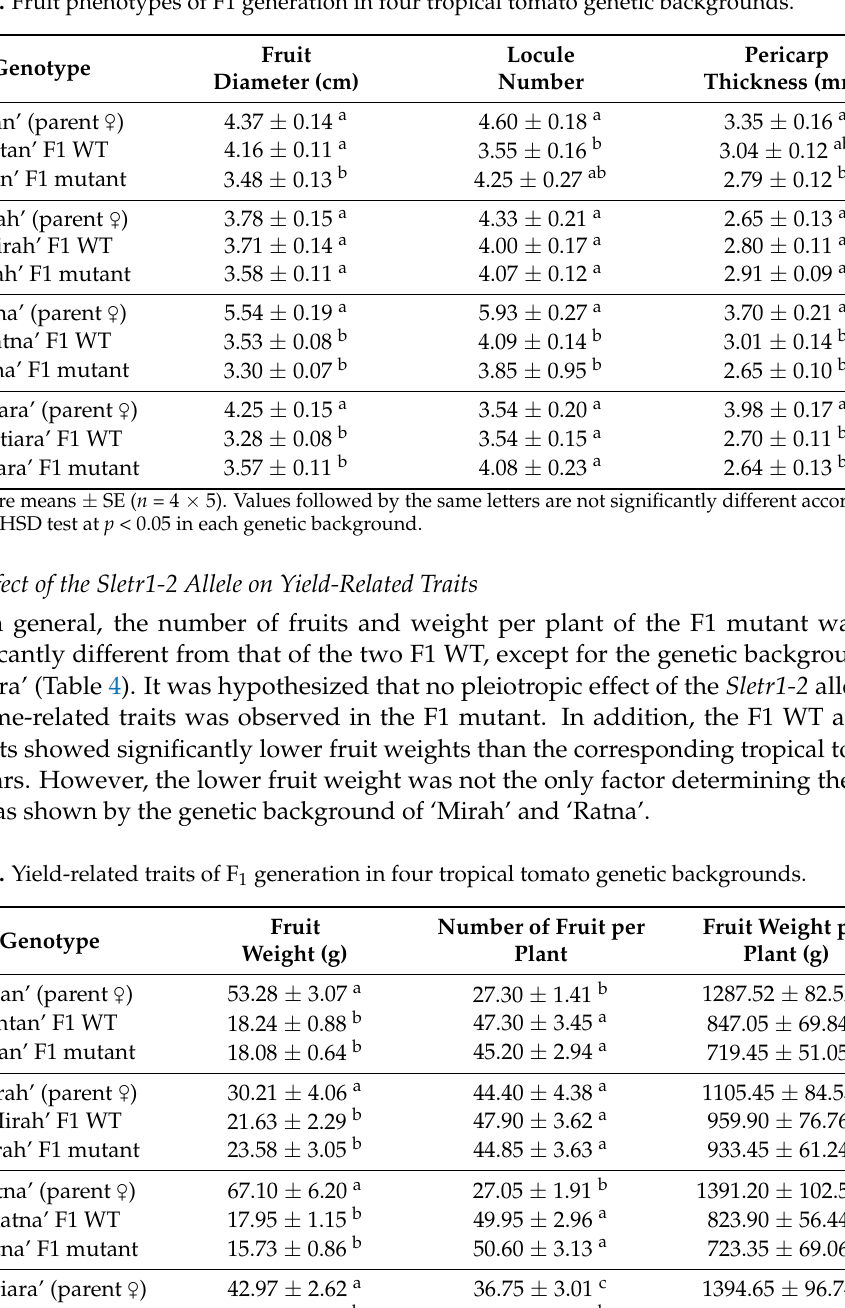
Table 3. Fruit phenotypes of F1 generation in four tropical tomato genetic backgrounds.